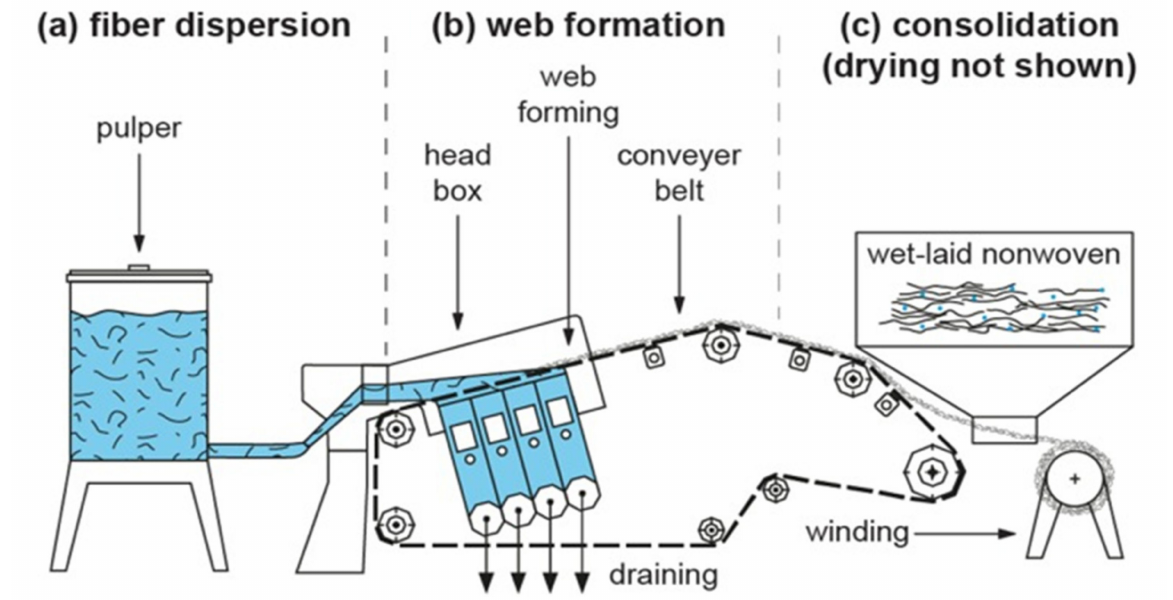
Figure 1. Illustration of wet-laid process. Reprinted with permission from [17]. Copyright 2021